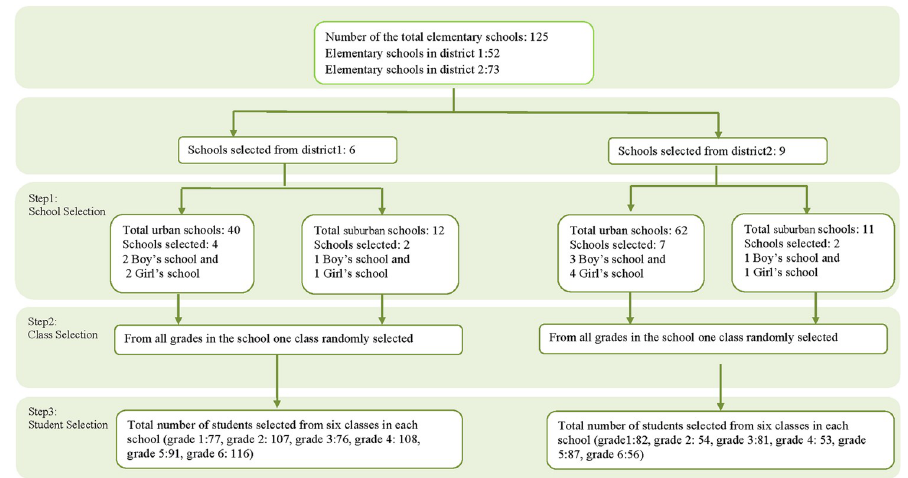
Fig 1. Flowchart of the sampling process and study subject selection among 125 elementary